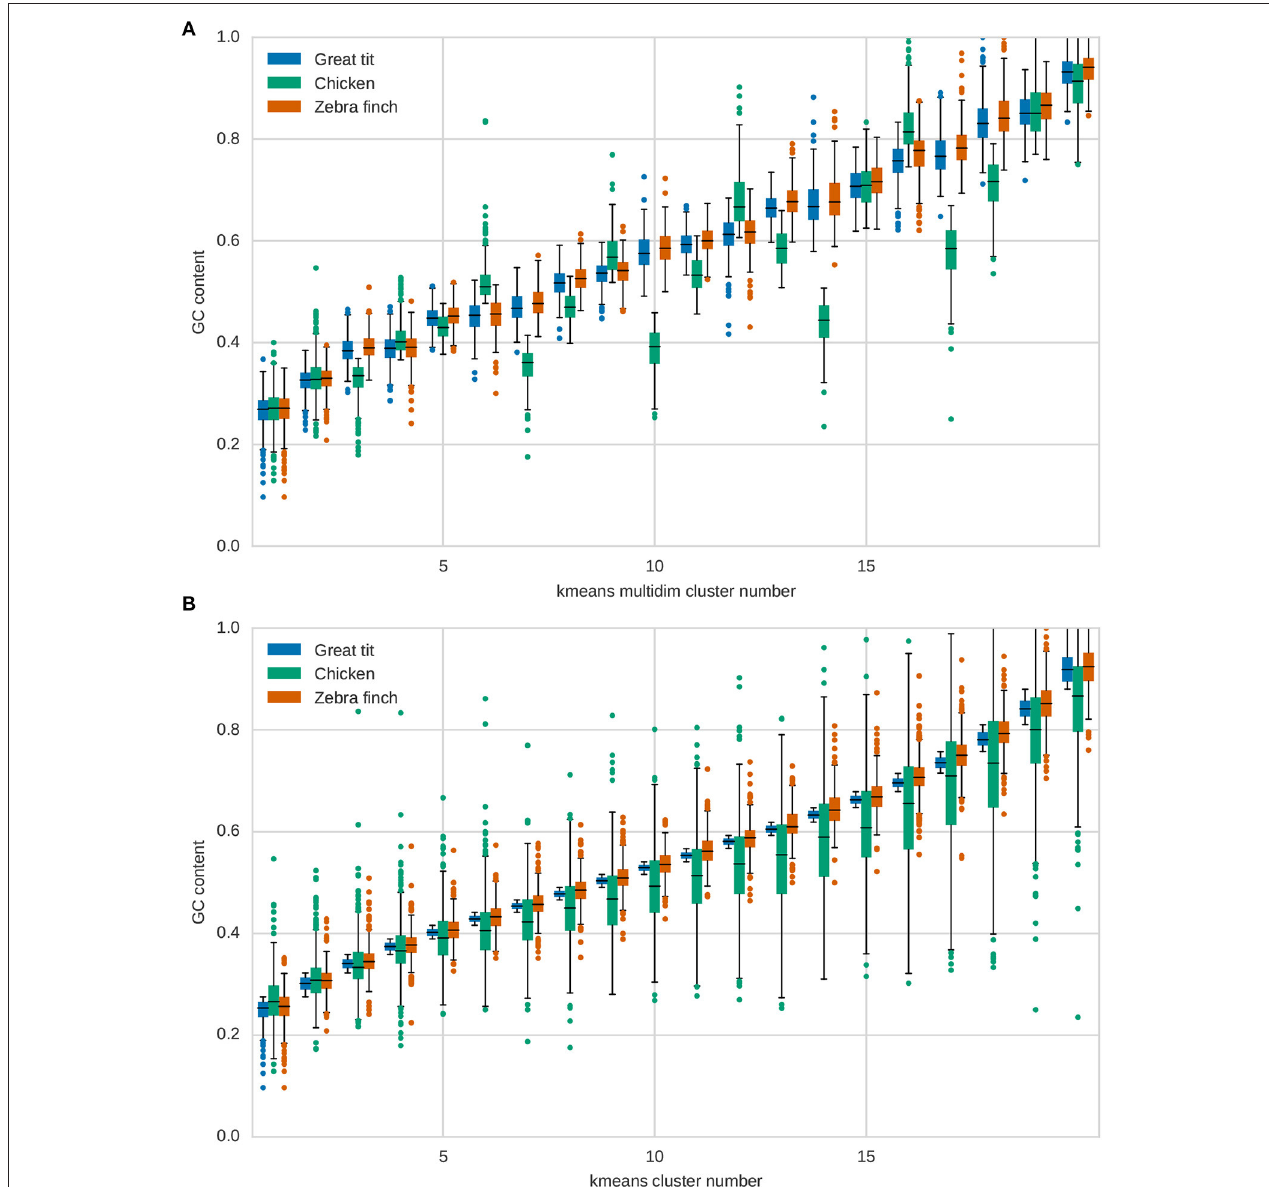
FIGURE 7 | Boxplots of GC content per cluster for each species after applying a kmeans clustering approach using a pre-defined cluster number of 20 for (A) multidimensional kmeans clustering and (B) one-dimensional clustering.